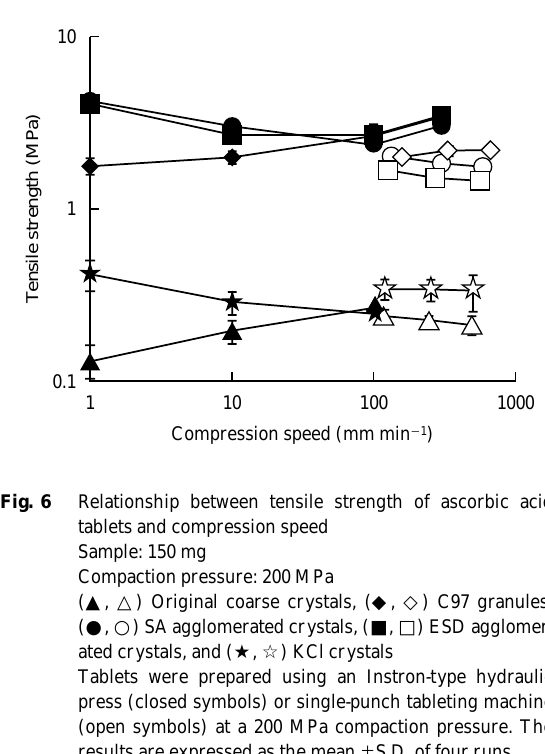
Relationship between tensile strength of ascorbic acid tablets and compaction pressure Sample: 150 mg Compression speed: 10 mm min (cid:4) 1 ( ▲ ) Original coarse crystals, ( ◆ ) C97 granules, ( ● ) SA agglomerated crystals, and ( ■ ) ESD agglomerated crys- tals †: Some tablets are capped during compaction. The results are expressed as the mean (cid:5) S.D. of four runs. There was a significant difference with the value for C97 granules at p (cid:7) 0.001 ( *** ), p (cid:7) 0.01 ( ** ) and p (cid:7) 0.5 ( *